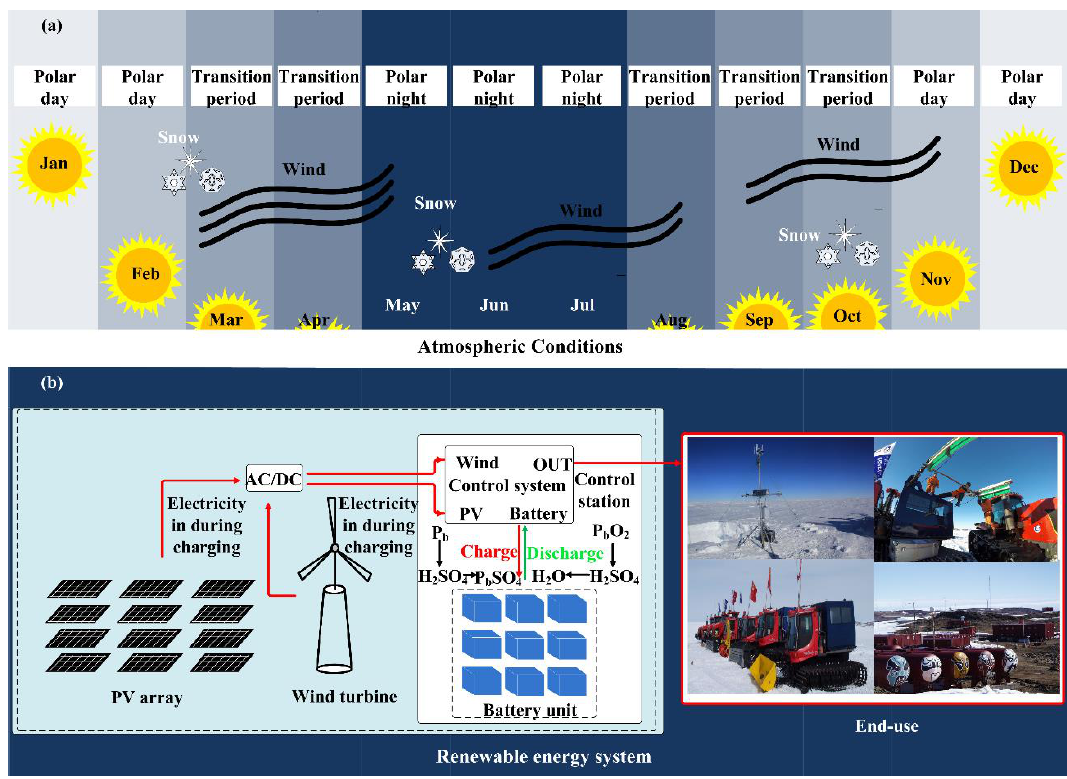
Figure 3. ( a ) Atmospheric conditions, ( b ) Schematic of the renewable energy system.